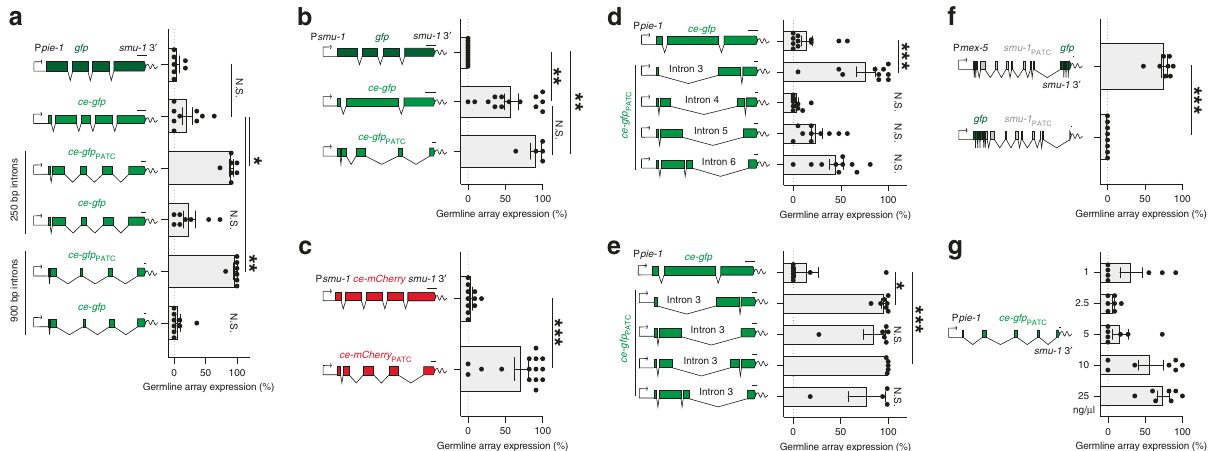
Fig. 2 PATCs promote germline expression from simple extrachromosomal arrays. a Quanti fi cation of germline GFP fl uorescence from arrays carrying P pie-1 :: fl uorescent protein:: smu-1 3 ′ -UTR transgenes. The ce-gfp transgenes contain synthetic introns (top) or substitutions with 250 bp and 900 bp endogenous introns with or without PATCs. n = 7, 9, 7, 8, 7, and 9 biologically independent transgenic lines (from top to bottom). b Germline GFP fl uorescence from arrays with P smu-1 :: gfp transgenes. n = 13, 14, and 5 biologically independent transgenic lines (from top to bottom). c Germline array mCherry fl uorescence from a codon-optimized ce-mCherry transgene 71 under control of P smu-1 . n = 11, and 15 biologically independent transgenic lines (from top to bottom). d Germline array fl uorescence of P pie-1 :: ce-gfp transgenes with single smu-2 introns. n = 11, 10, 10, 10, and 10 biologically